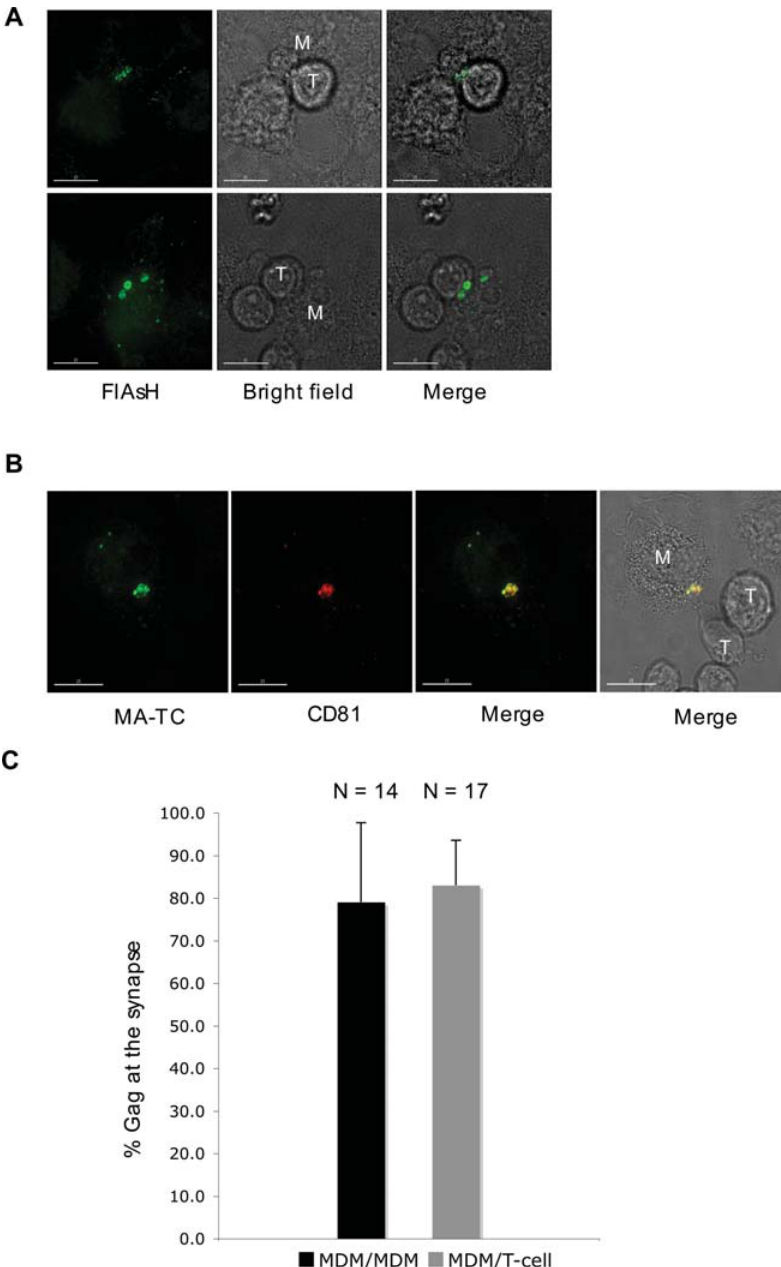
Figure 6. Gag accumulates at the MDM/T-cell synapse. (A) Infected MDMs were labeled with FlAsH and Jurkat cells were added to the cultures. One to two hours after addition of the T-cells, the co-cultures were fixed with 3.7% formaldehyde and imaged or (B) stained with anti-CD81 antibody. In panel B, Gag/CD81 colocalization is indicated as yellow in merge. M=MDMs; T=Jurkat T-cells. Scale bars in panels A and B=15 m m. (C) Quantification of Gag concentration at the synapse. The microscopy images were opened in ImageJ and a plot profile was obtained. A column average plot was generated, in which the x-axis represents the horizontal distance through the image and the z-axis the vertically averaged pixel intensity. The % Gag at the synapse=(pixel intensity of Gag signal at synapse)/(total intensity of Gag in the cell + synapse) 6 100. N values indicate the number of cells analyzed in each data set. For more information on how the Gag quantification was performed, see Fig. S3A.